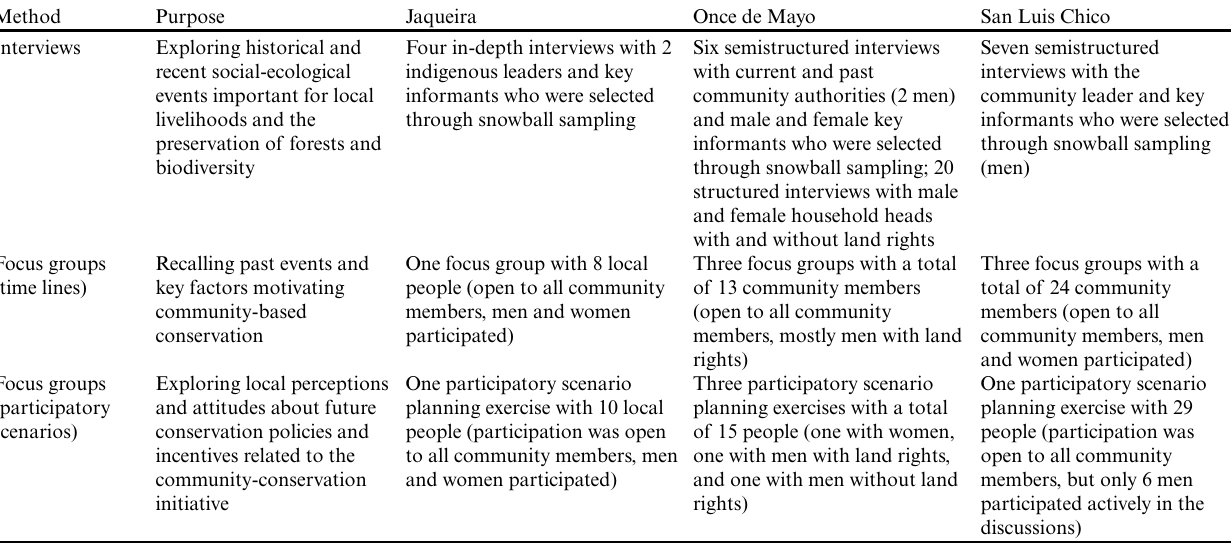
Table 2 . Methodological details of